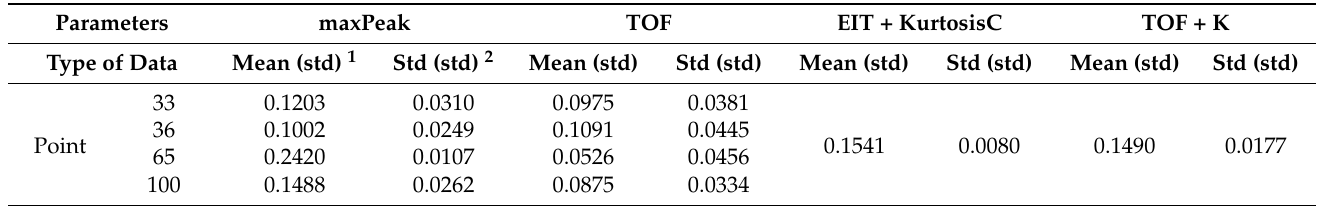
Table 6. Comparison of dispersion analysis of “point” parameters and “line” parameters.